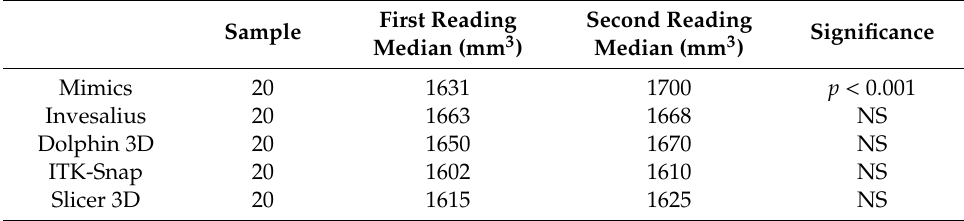
Table 5. Comparison between first volumetric reading (operator 1) and second volumetric readings (operator 2) of condylar models for each software investigated (Inter-observer reliability). Significance set at p < 0.05 according to the Wilcoxon Signed-Rank Test.